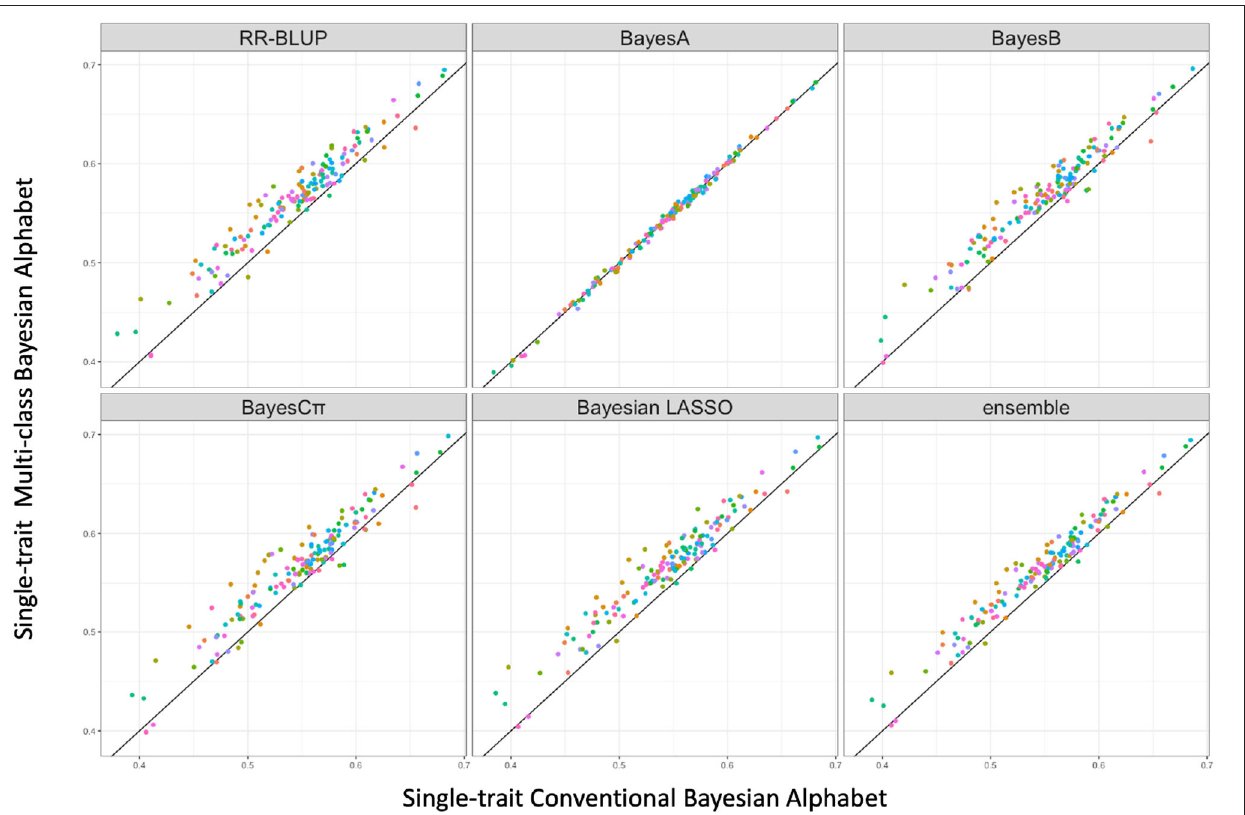
FIGURE 1 | The pairwise predication accuracy comparison between conventional and multi-class Bayesian Alphabet on single-trait simulated data. The 30 simulated datasets were distinguished by color; the x-axis represents the genomic prediction accuracy obtained from conventional Bayesian Alphabet methods; the y-axis represents the genomic prediction accuracy obtained from multi-class Bayesian Alphabet methods; the diagonal line is used for reference such that a dot above the line represents a validation with higher accuracy for multi-class Bayesian Alphabet. Significant differences were found between multi-class Bayesian Alphabet and conventional Bayesian Alphabet with RR-BLUP, BayesB, BayesC π Bayesian LASSO, and ensemble approach, respectively ( p < 0.1).